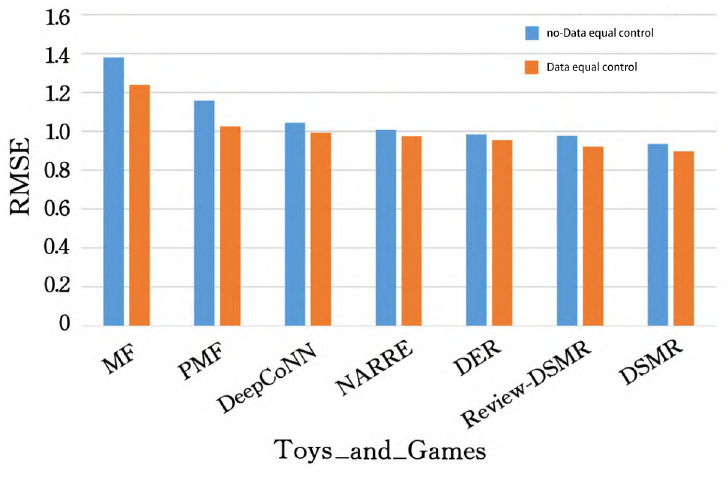
Fig 3. Effect comparison with/without data equal